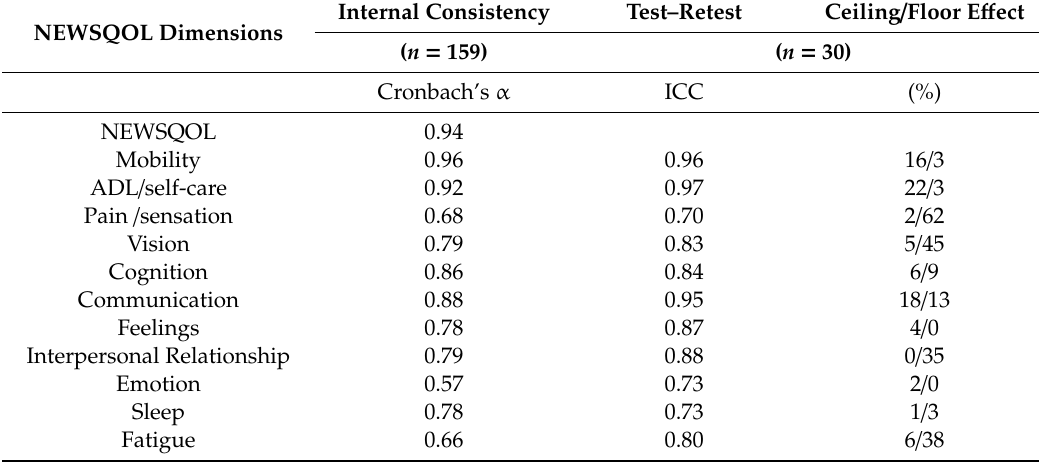
Table 2. Values of internal consistency, test–retest reliability, ceiling, and floor e ff